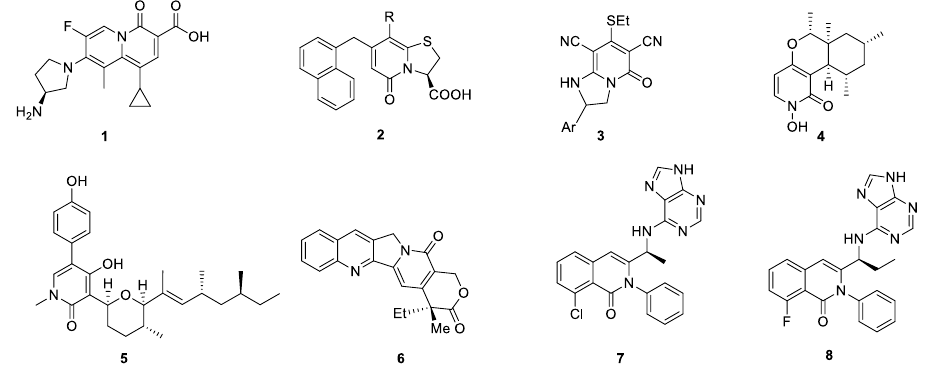
Figure 1. Examples of biologically active 2-pirydones.